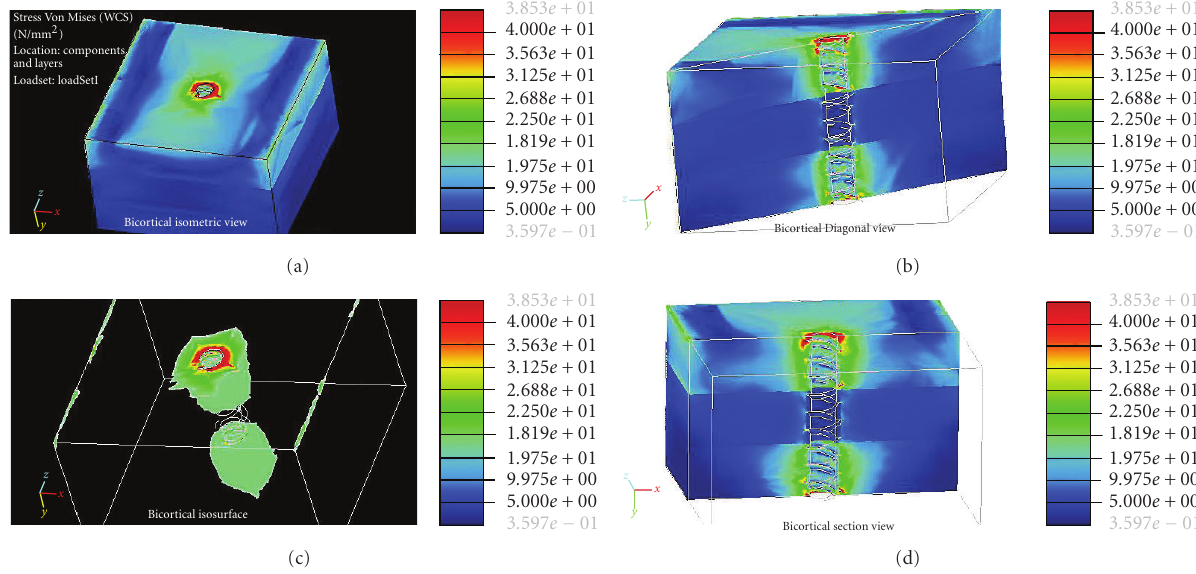
Figure 7: Plots of von Mises stress (MPa) in a typical trilaminate block. The four views shown are (clockwise from top-left): (a) isometric view, (b) diagonal section view, (c) volumetric contours, and (d) section view.